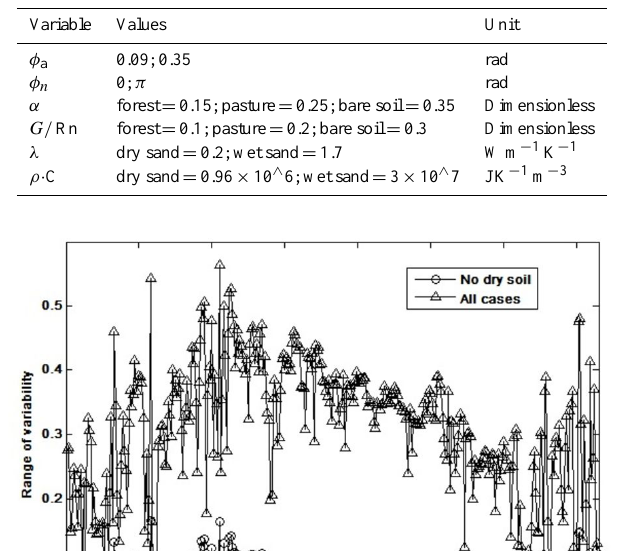
Table 8. Values of the parameters applied to construct a synthetic sample of LST time series by using Eqs. (8)–(13).